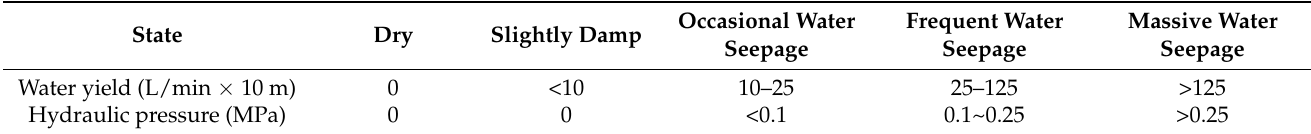
Table 2. State distribution of groundwater in the middle rock